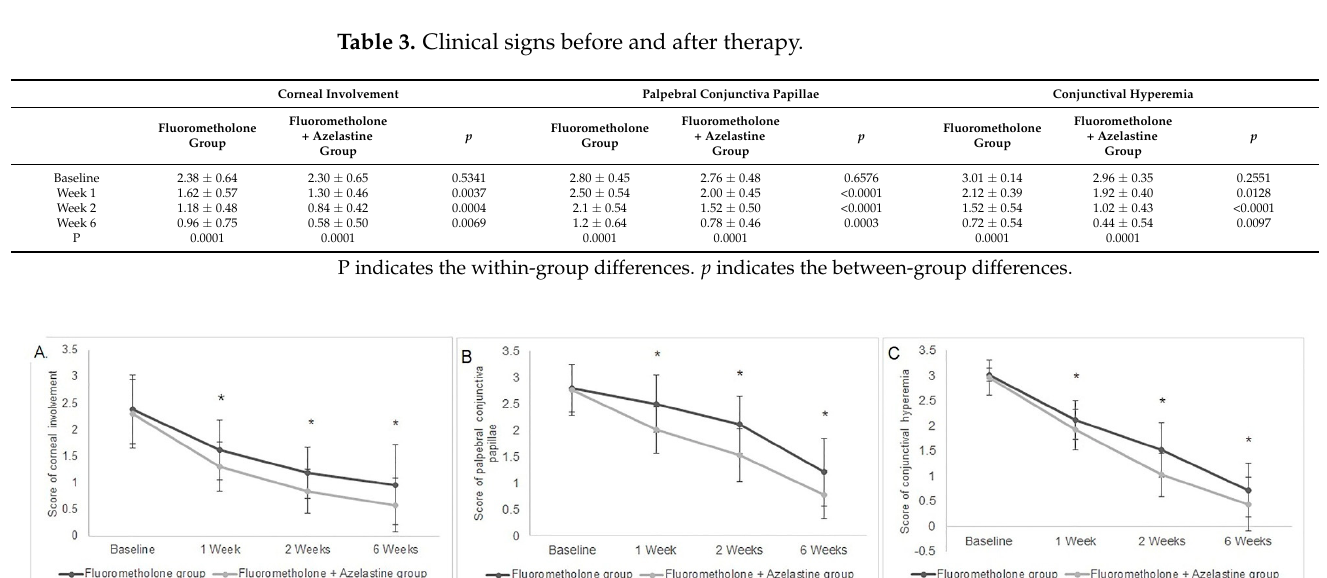
Table 3. Clinical signs before and after therapy.